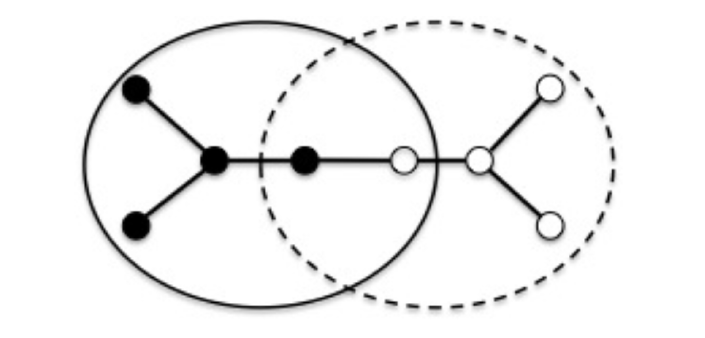
Figure 1. Additive Schwarz method with overlapping